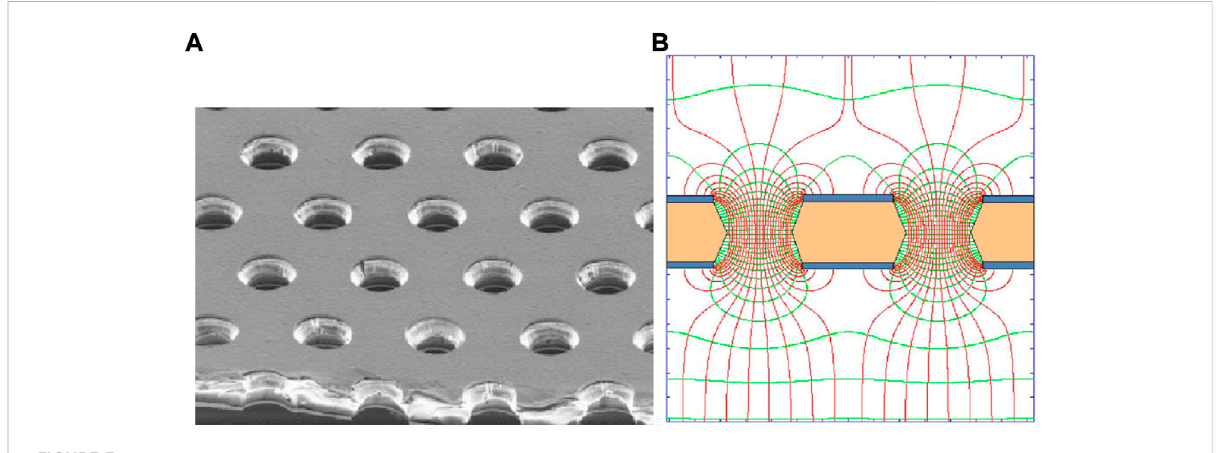
FIGURE 3 GEMfoil. (A) Electron microscopeview ofaGEMfoilwith holeswith70 µmdiameter and140 µmpitch. Source: [45]. (B) Simulatedelectric fi eld in the GEM when a voltage is applied at its electrodes. Source: [46].